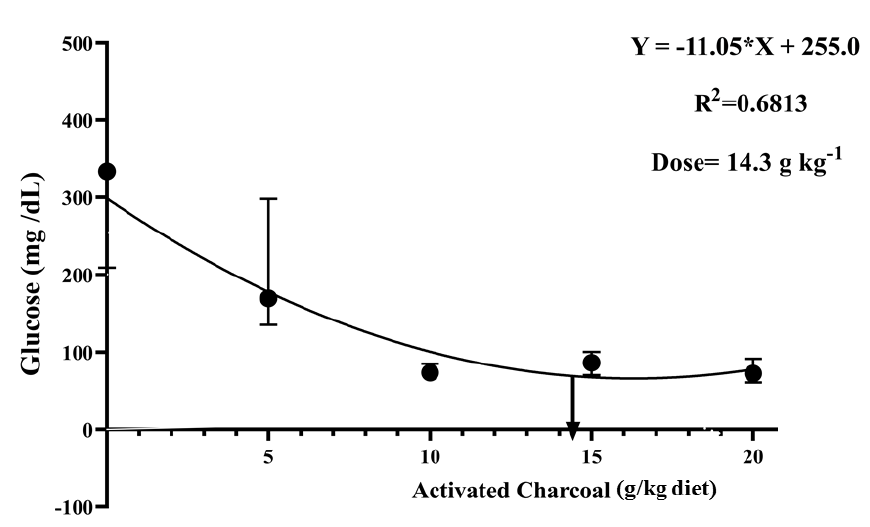
Figure 4. Second-order polynomial regression equation between blood glucose levels of Nile tilapia fed different dietary activated charcoal (AC) levels for 8 weeks and then exposed to a sub-lethal imidacloprid (IMID) level for 2 weeks. Values expressed as means ± S.E.M.